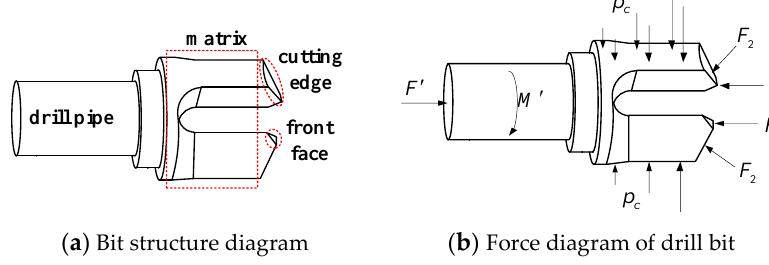
Figure 2. A three-dimensional structural mechanical model of a bit.